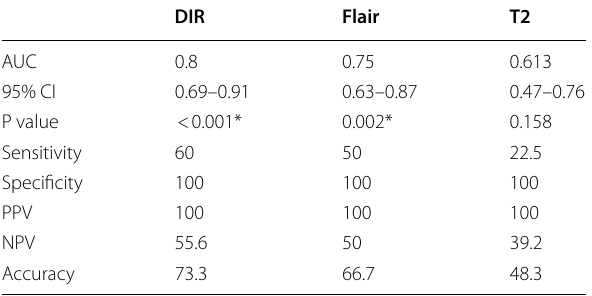
Table 8 ROC curve analysis for the prediction of cortical grey matter lesions using different MRI pulse sequences (DIR, Flair and T2) among studied 40 MS patients (control group is the reference